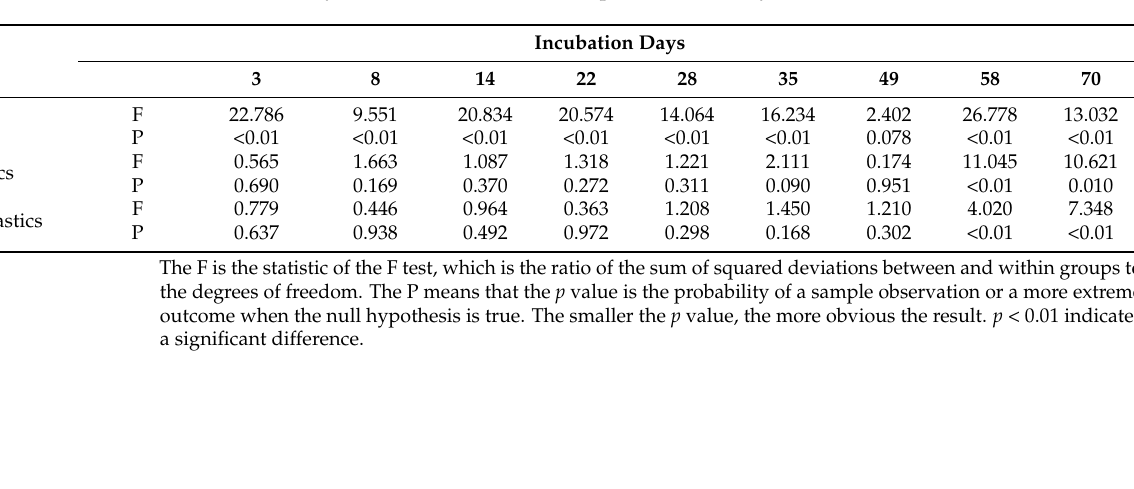
Figure 1. CO 2 concentrations in freshwater ecosystems after microplastics (HDPE, PVC, PA, PET) added. ( a ) Poyang Lake. ( b ) paddy soil. Table 1. One-Way ANOVA of soil and microplastics on CO 2